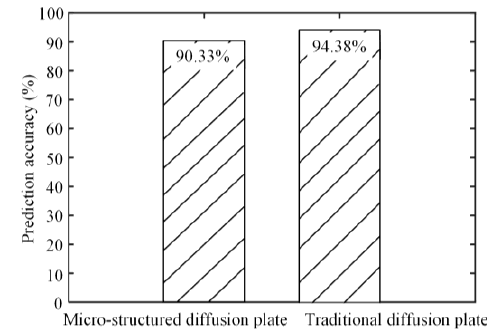
Figure 14. The prediction accuracies of traditional and micro-structured diffusion plates.